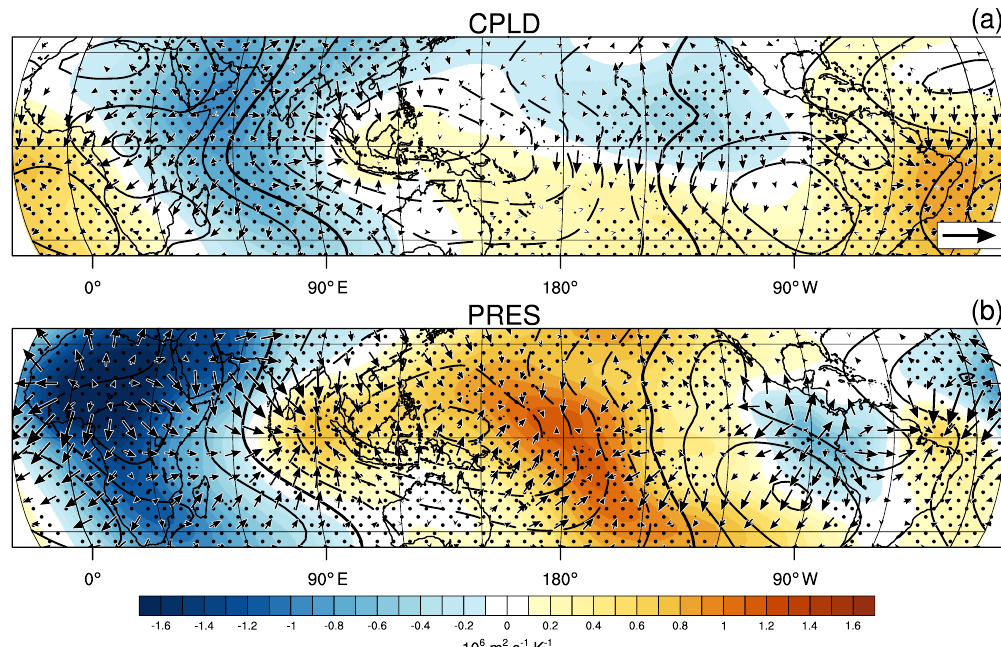
Figure 3. As Fig. 1, except showing the 200hPa annual mean velocity potential ( χ ) response (shading) and 200hPa divergent wind annual mean response vectors (reference vector denotes 1ms − 1 K − 1 ). Contours show 200hPa χ from the preindustrial control climatology, interval 2 × 10 6 m 2 s − 1 with dashed contours negative and the zero line thickened. Stippling as in Fig.